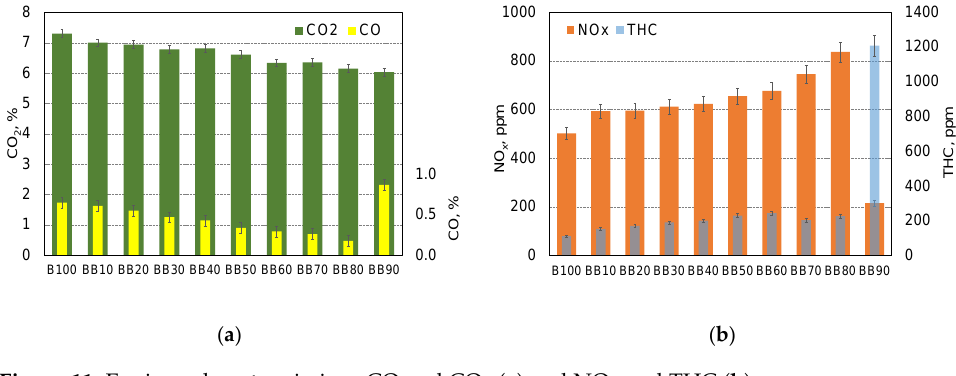
Figure 11. Engine exhaust emissions CO and CO 2 ( a ) and NO x and THC ( b ).